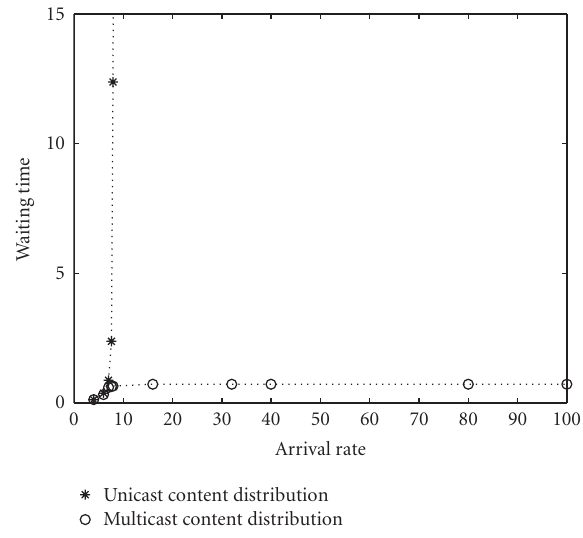
Figure 3: The waiting time in hours, as a function of the arrival rate to the system per hour, for a nonhomogeneous load distribution, in comparison to a unicast content distribution.